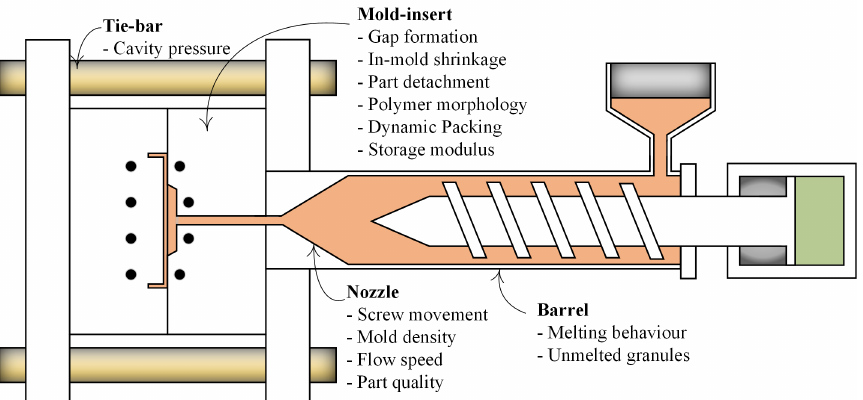
Figure 1. Monitored parameters with ultrasonic sensors at the different locations of injection